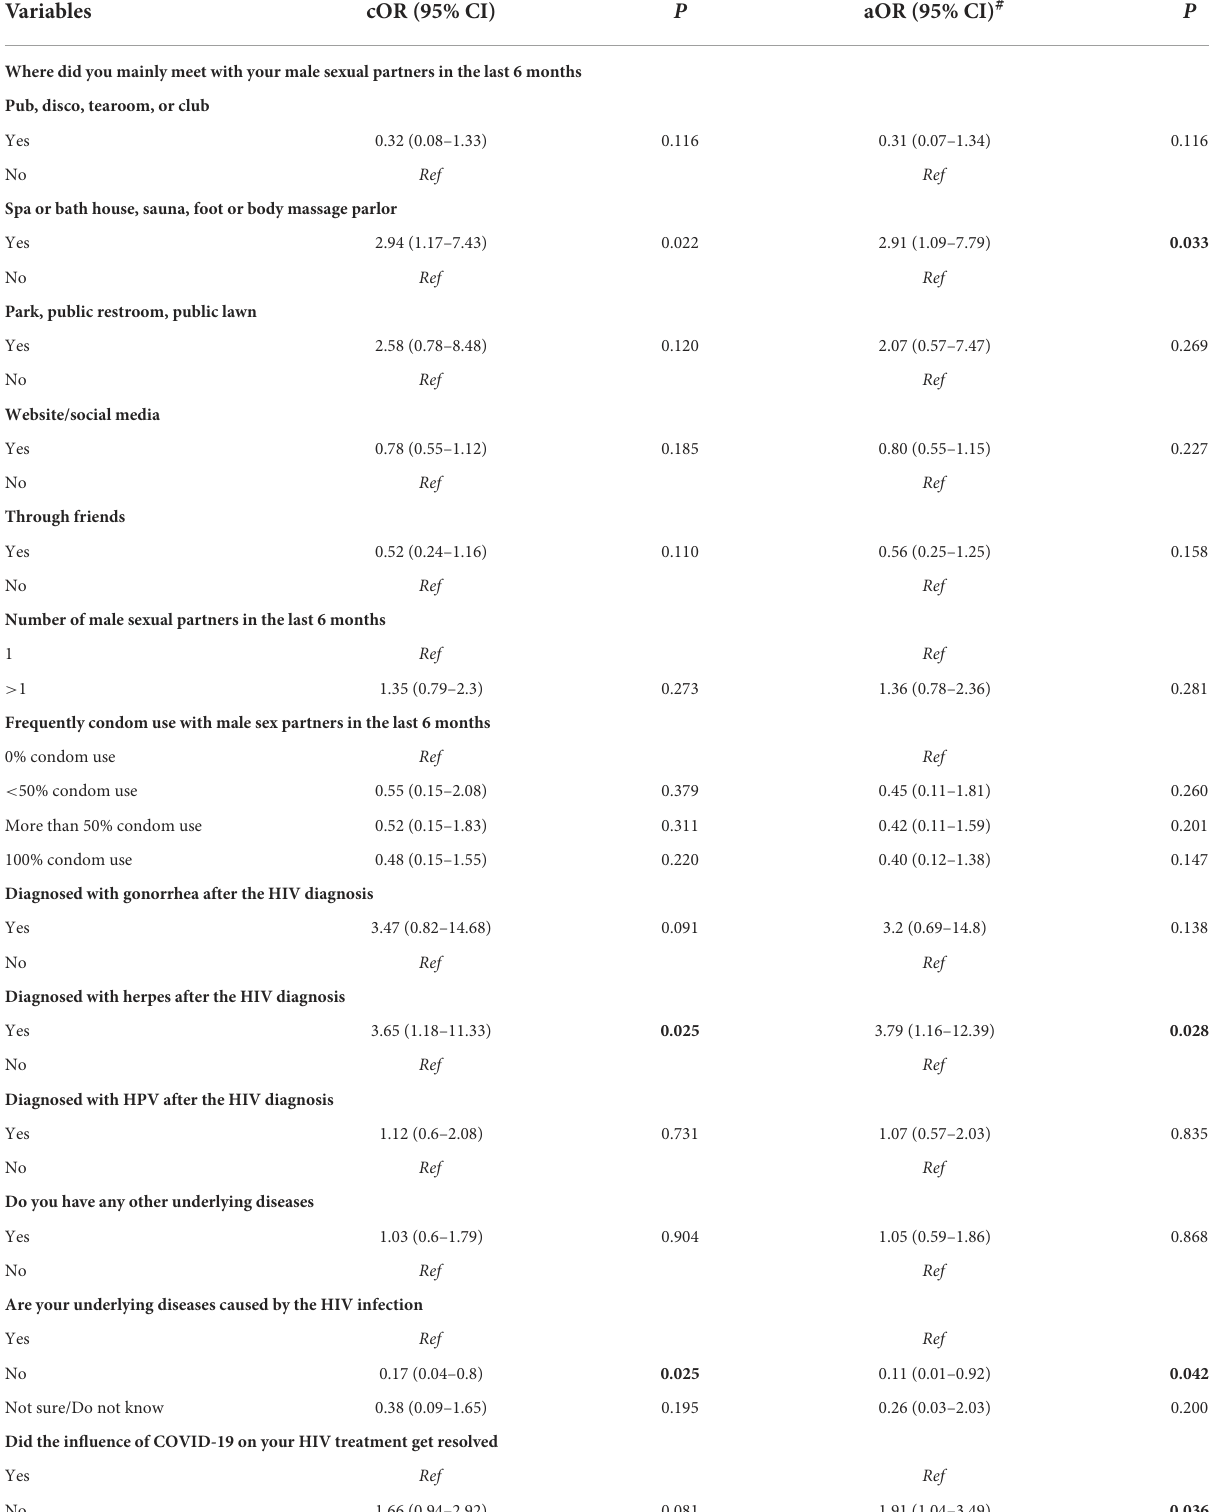
TABLE 3 Factors associated with syphilis among HIV-positive MSM in Guangdong Province from June 2020 to August 2021 ( N = 944).